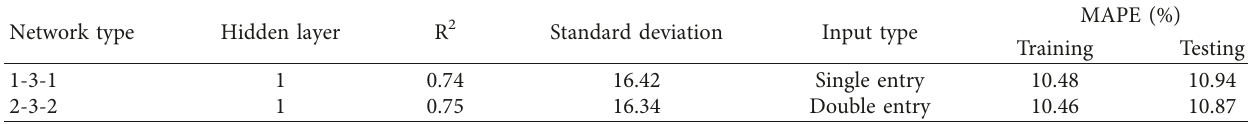
Table 3: Results of the test group data into the ANN.